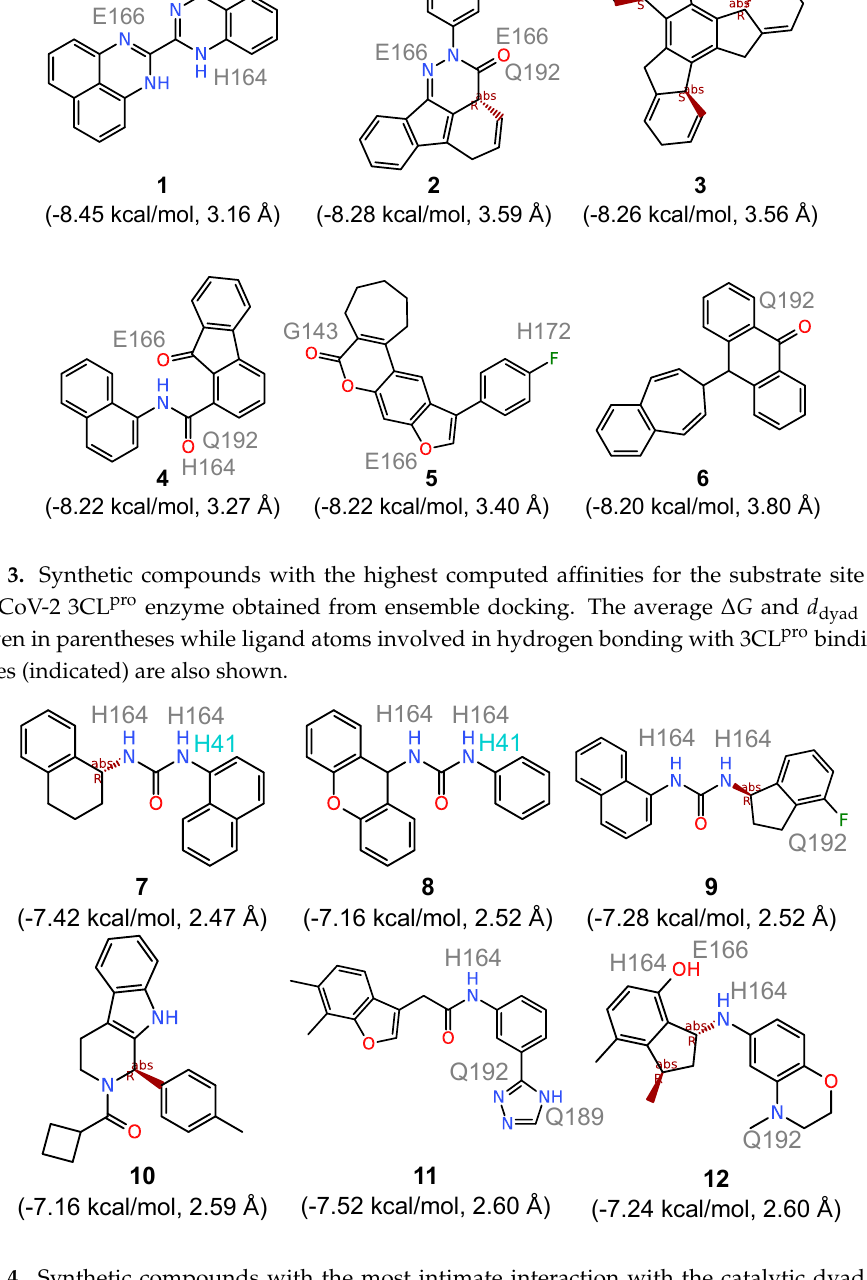
Figure 4. Synthetic compounds with the most intimate interaction with the catalytic dyad of the SARS-CoV-2 3CL pro enzyme obtained from ensemble docking. The average ∆ G and d dyad values are given in parentheses while ligand atoms involved in hydrogen bonding with 3CL pro binding site residues (indicated) are also